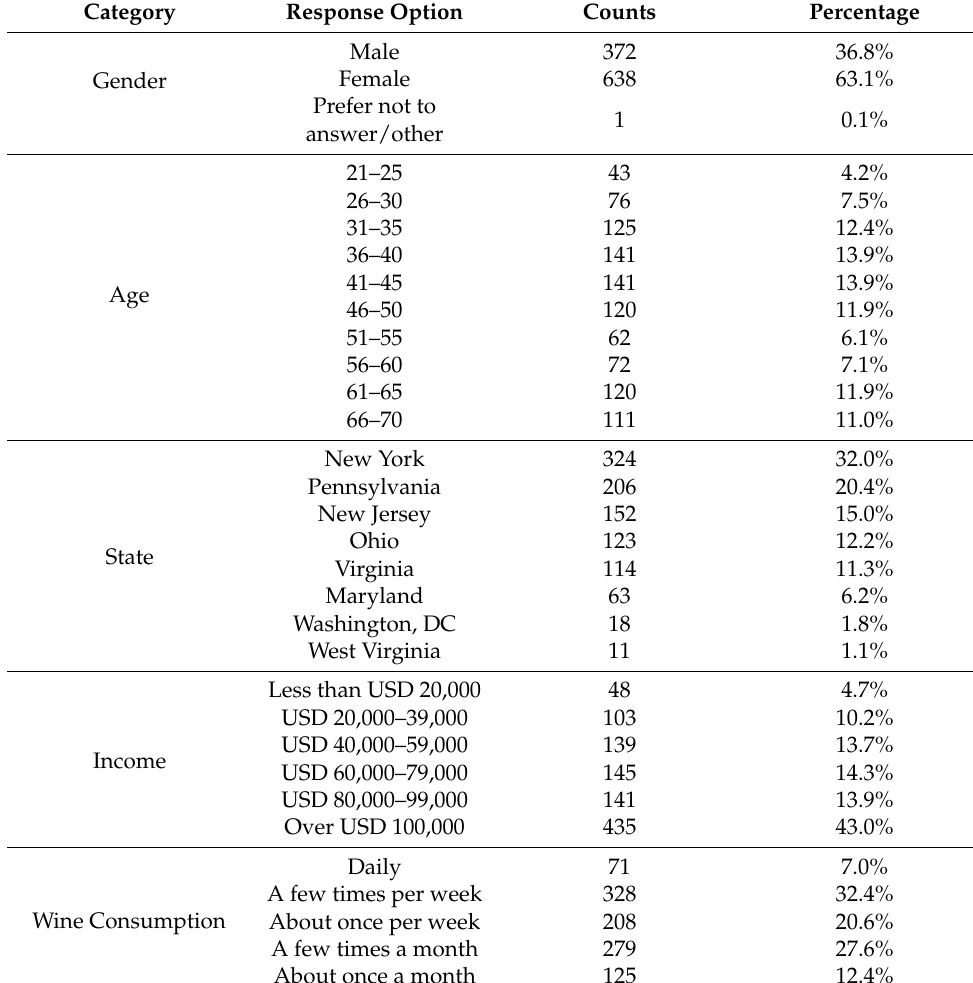
Table 2. Demographic summary of consumer survey respondents ( n =